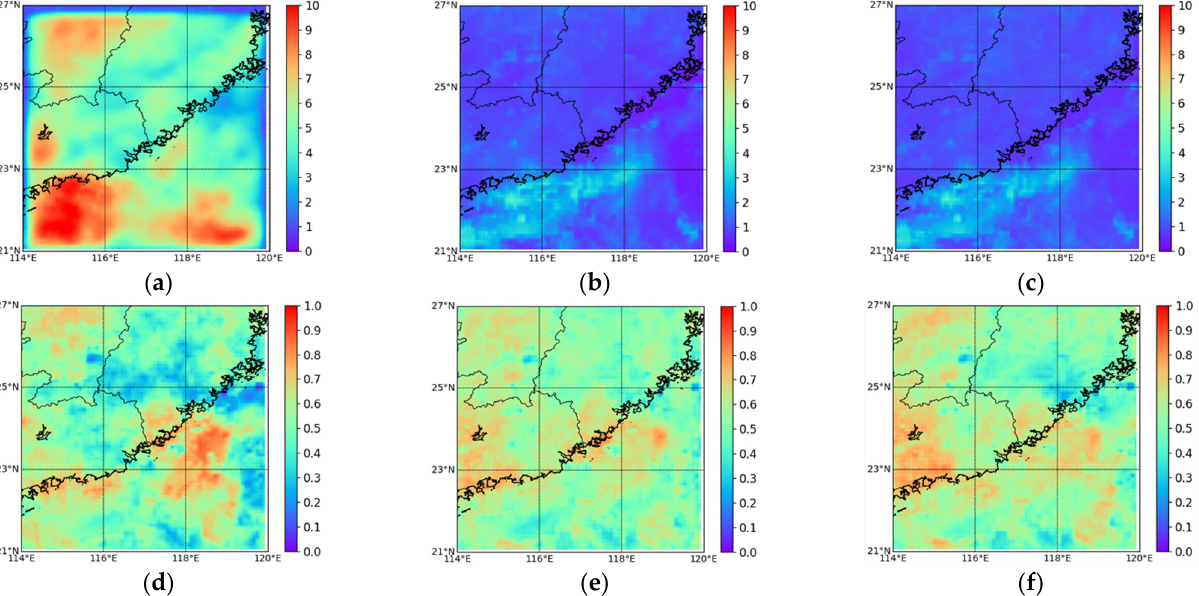
Figure 7. The Pearson correlation coefficient (CC) and Root Mean Square Error (RMSE) values of Unet, PERSIANN-CNN and Attention-Unet model over the southeastern coast of China during the validation period (June–August 2020). ( a – c ) RMSE and ( d – f ) CC. ( a ) RMSE: Unet; ( b ) RMSE: PERSIANN-CNN; ( c ) RMSE: Attention-Unet; ( d ) CC: Unet; ( e ) CC: PERSIANN-CNN; ( f ) CC: Attention-Unet.